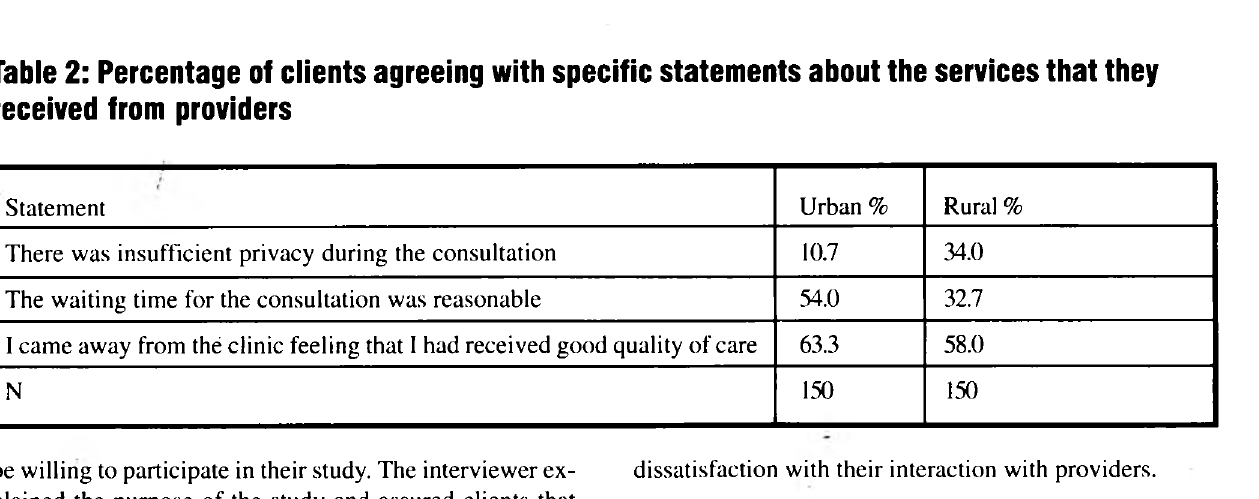
Table 2: Percentage of clients agreeing with specific statements about the services that they received from